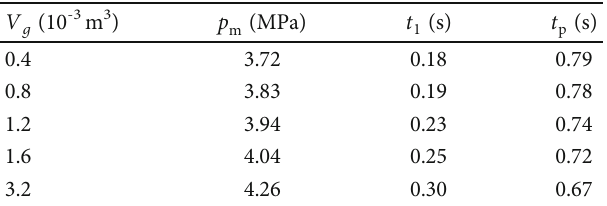
Figure 11: The pressure evolutions in the combustor for di ff erent free volume of combustion chamber. ff erent free volume of Table 6: Calculated results of p m and t 1 for di the combustion